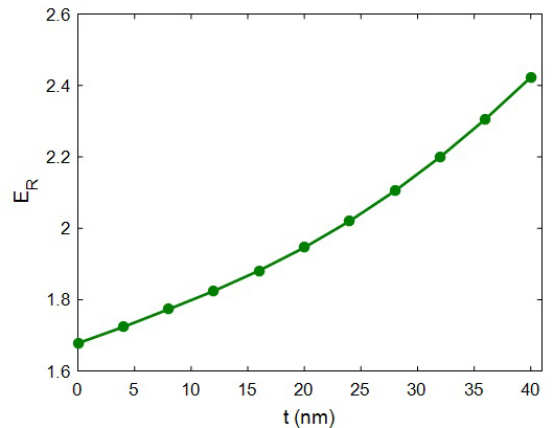
Figure 3. Relative modulus correlating to interphase depth (Equation (17)).